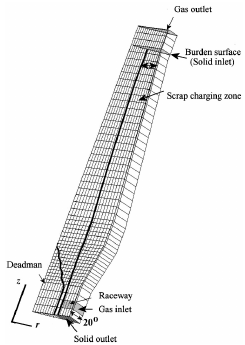
Figure 2. Mesh placement of the model.